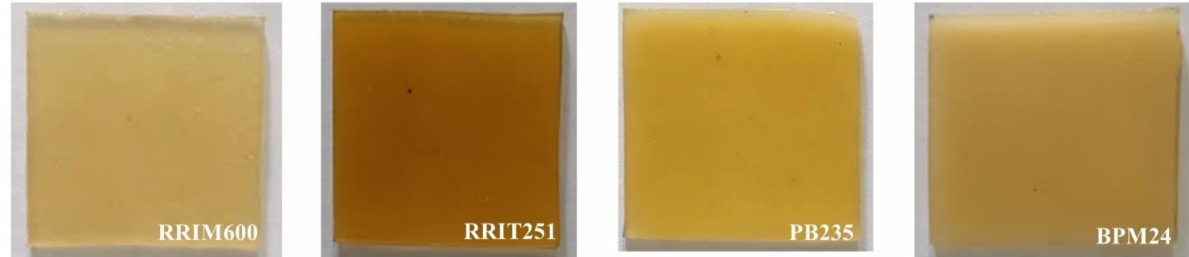
Figure 7. The color of cream concentrated latex from four different Hevea brasiliensis